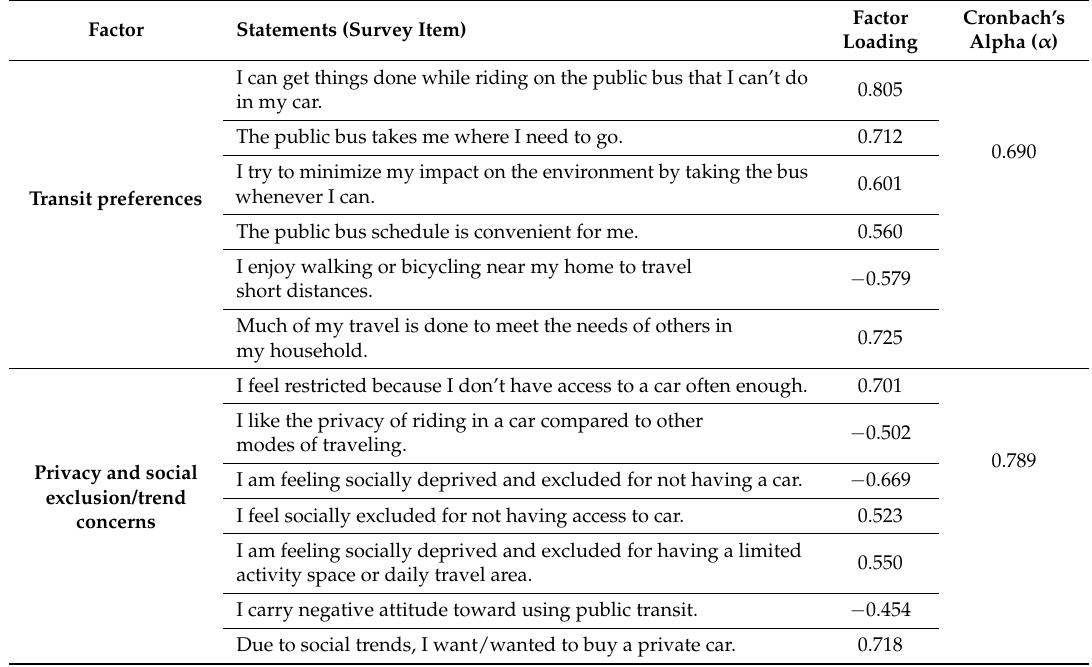
Table 4. Summary of the factor analysis (statements organized as per correlation